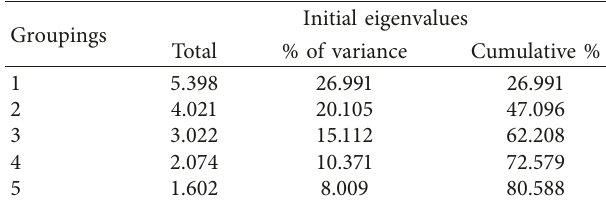
Table 4: Total variance explained for factors.